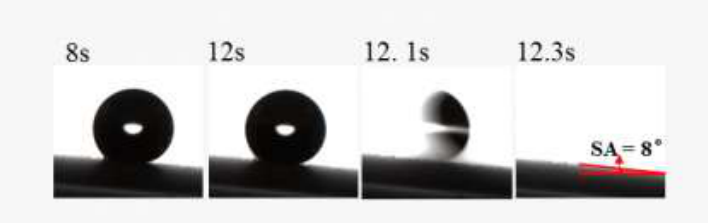
Figure 4. Measurement of water sliding angle for superhydrophobic coatings with 30% silica content is shown, in which the WSA is obtained as 8°. Specifically, when the inclination angle of the superhydrophobic surface is 8°, the water droplets easily roll off the surface.